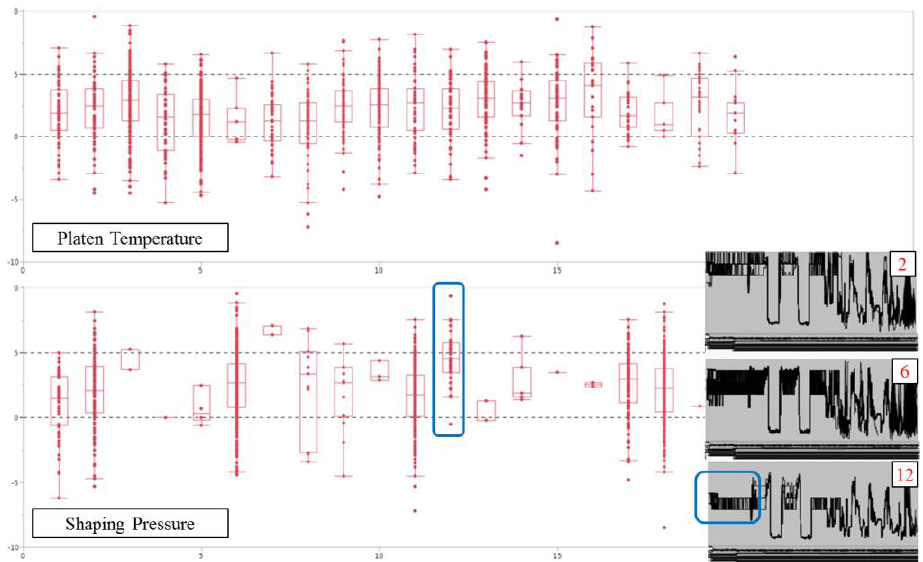
Figure 6. Box plot from the clusters of platen temperature and shaping pressure.